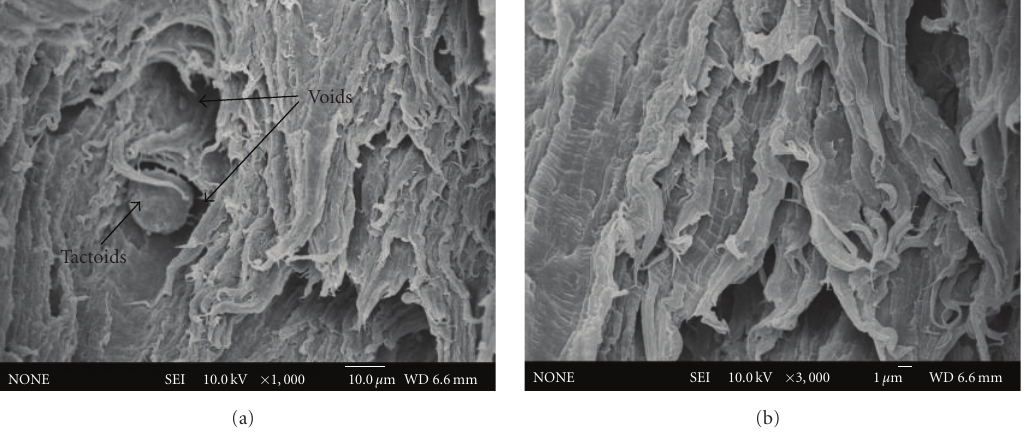
Figure 5: FESEM micrographs of control sample.